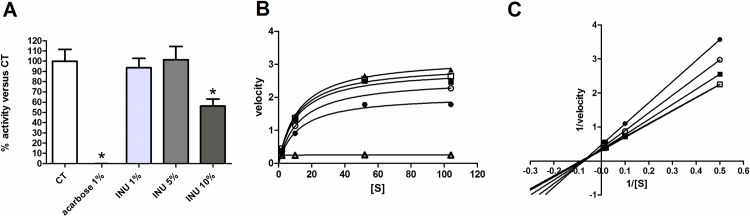
Sucrase activity in vitro.Inhibitory effect of inulin extract (INU) and acarbose on sucrase activity of small intestinal mucosa obtained from naïve mice (A). Michaelis-Menten (B) and Lineweaver-Burk (C) plots of the sucrase hydrolysis reaction with variable sucrose concentrations ([S] from 0 to104 mM) and at fixed concentration of inulin extract (0mM (▲), 3mM(□), 6mM(■), 11mM(○), 23mM(●), acarbose 5 mM(△)).